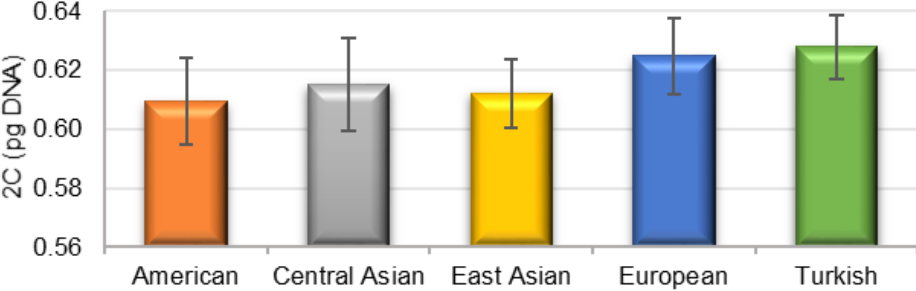
Figure 3. The average nuclear DNA content (2C) for the geographical groups of apricots. The vertical lines refer to the standard deviation.